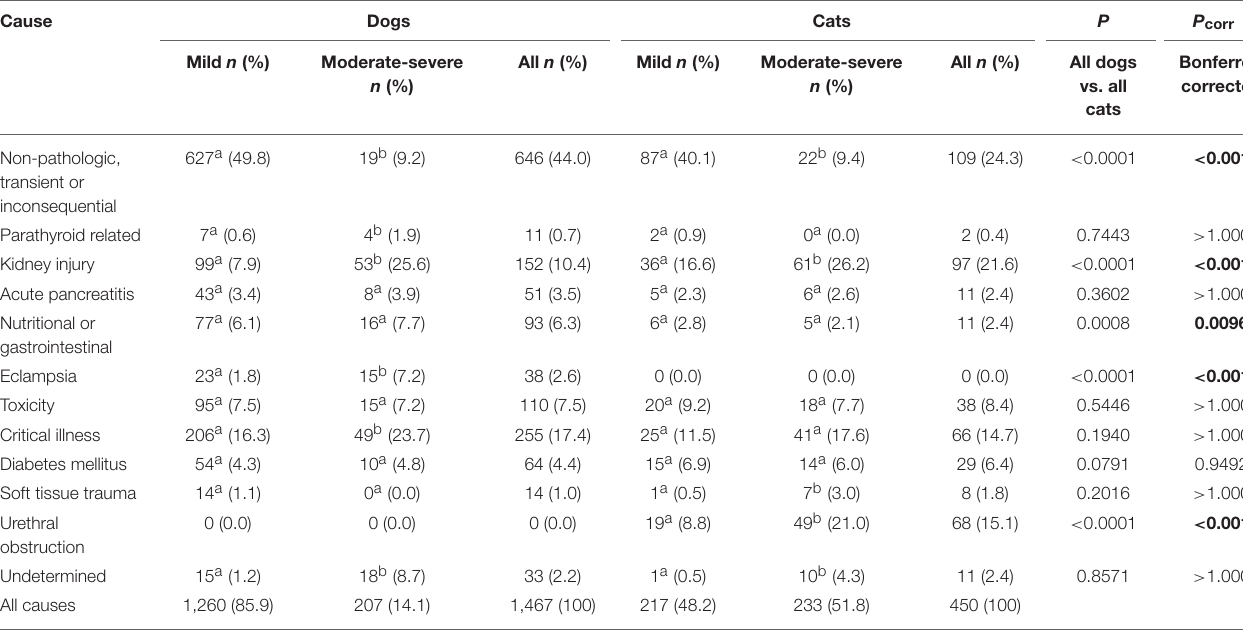
TABLE 2 | Conditions associated with